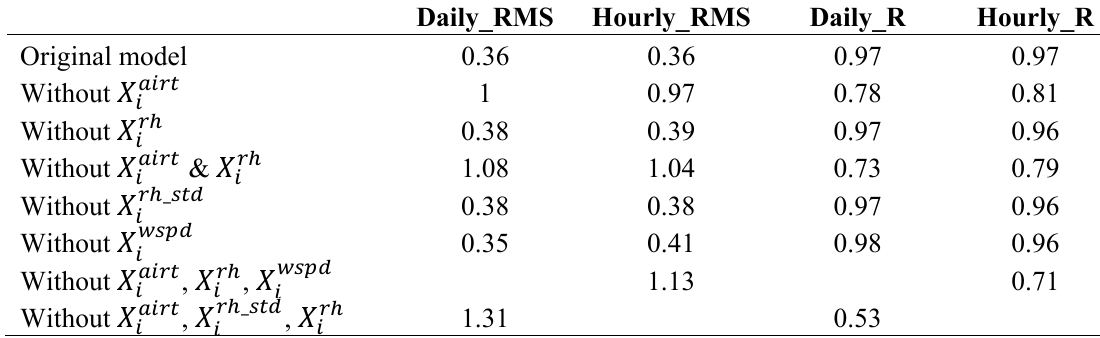
Table 6. Statistical results of model